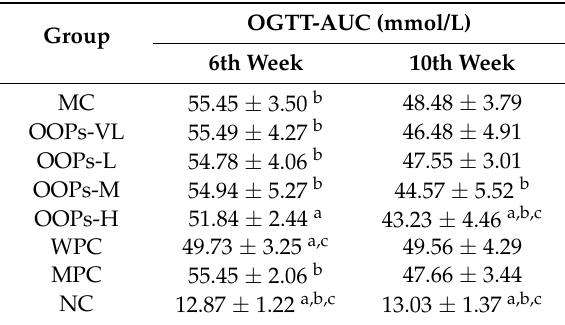
Table 3. Effect of OOPs treatment on the OGTT-AUC.